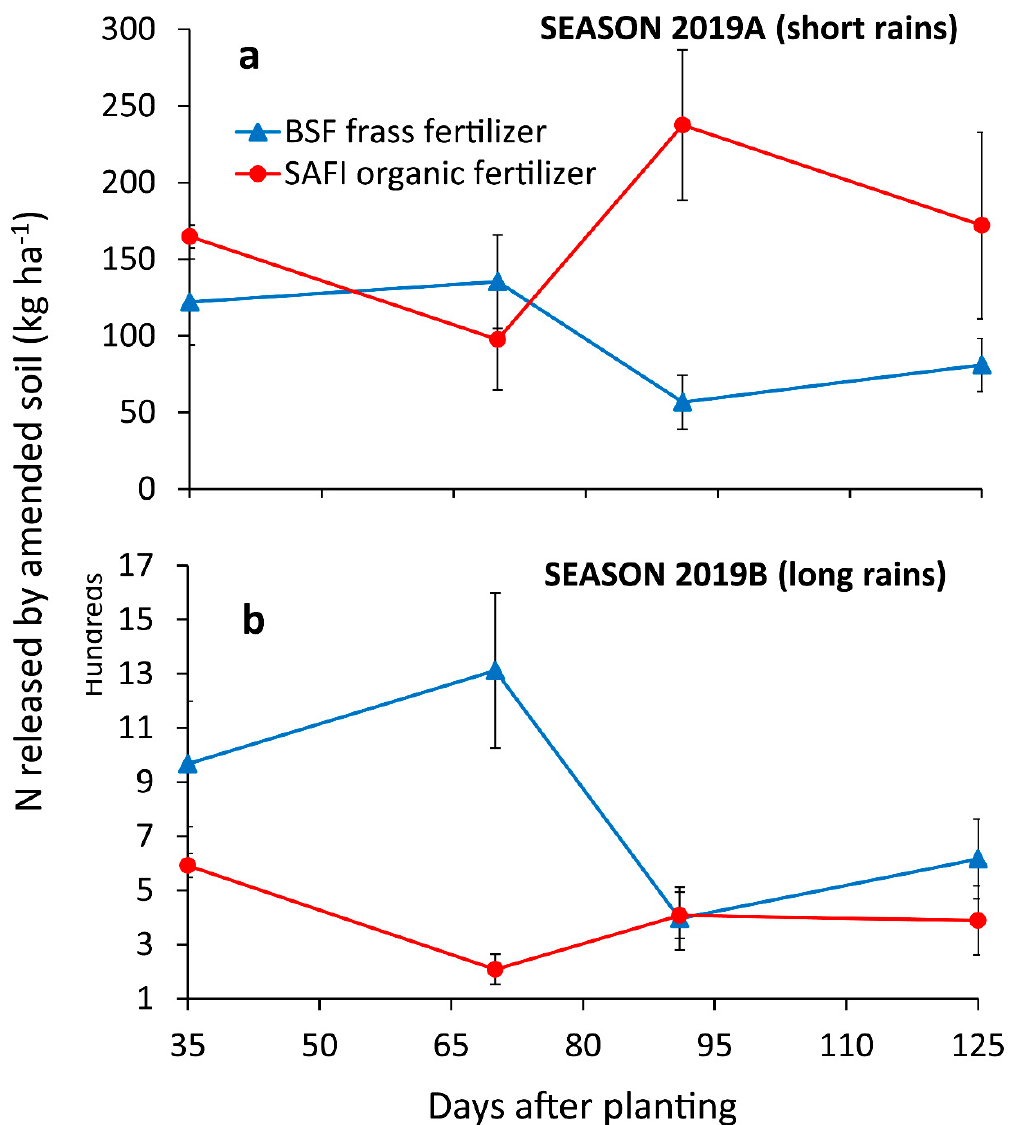
Figure 2. Nitrogen released by soil amended with black soldier fly (BSF) frass fertilizer and SAFI organic fertilizer during the short ( a ) and long rain ( b ) cropping seasons.